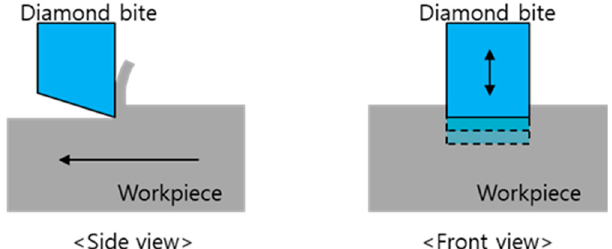
Figure 1. Schematic drawing of an ultra-precision machining experiment. The left shows the generation of chip by relative transport of tool and material. The right shows the process of dividing the whole cutting depth and cutting it sequentially.